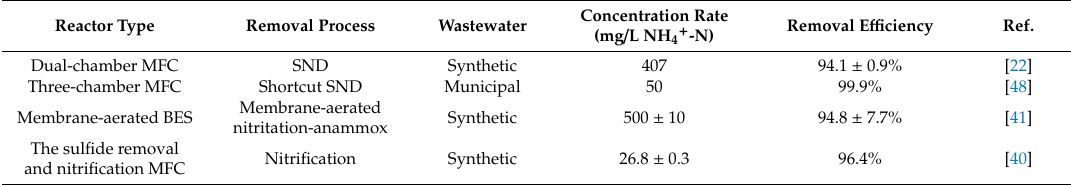
Table 3. E ffi ciency of nitrogen removal via di ff erent process in Bioelectrochemical systems